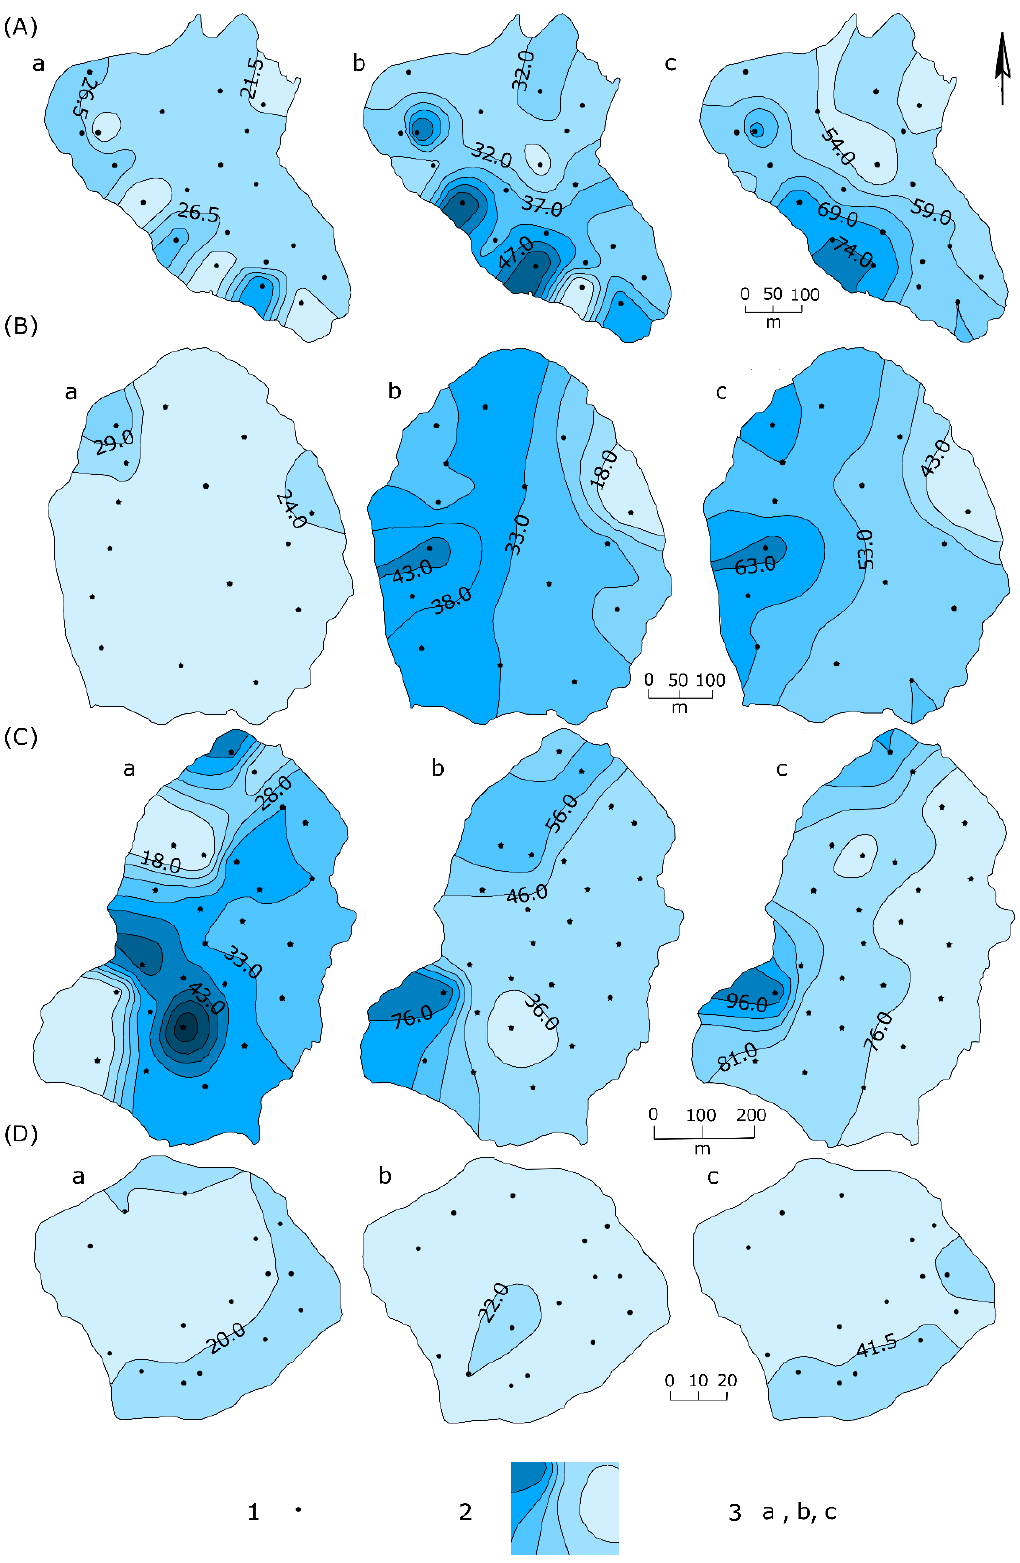
Figure 3. Variability in snow and ice cover thickness in studied Tatra lakes at the beginning of the 2018/2019 winter season. Lakes studied: ( A ) Czarny Staw Gąsienicowy, ( B ) Czarny Staw pod Rysami, ( C ) Morskie Oko, and ( D ) Smreczyński Staw; 1— holes drilled; 2 — ice isopachytes (cm); 3 — thickness of individual layers (cm) (a — ice cover; b — snow and slush; c — snow and ice cover).